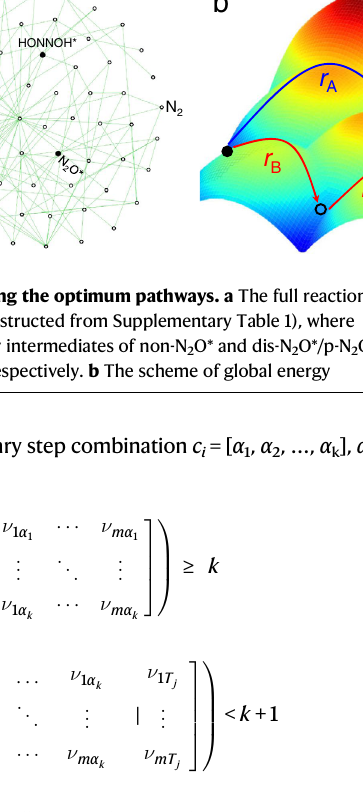
Fig. 3. The theoretical activities give basic agreement with experi- mental trends, verifying the mechanisms obtained by 2D-RPD analysis.